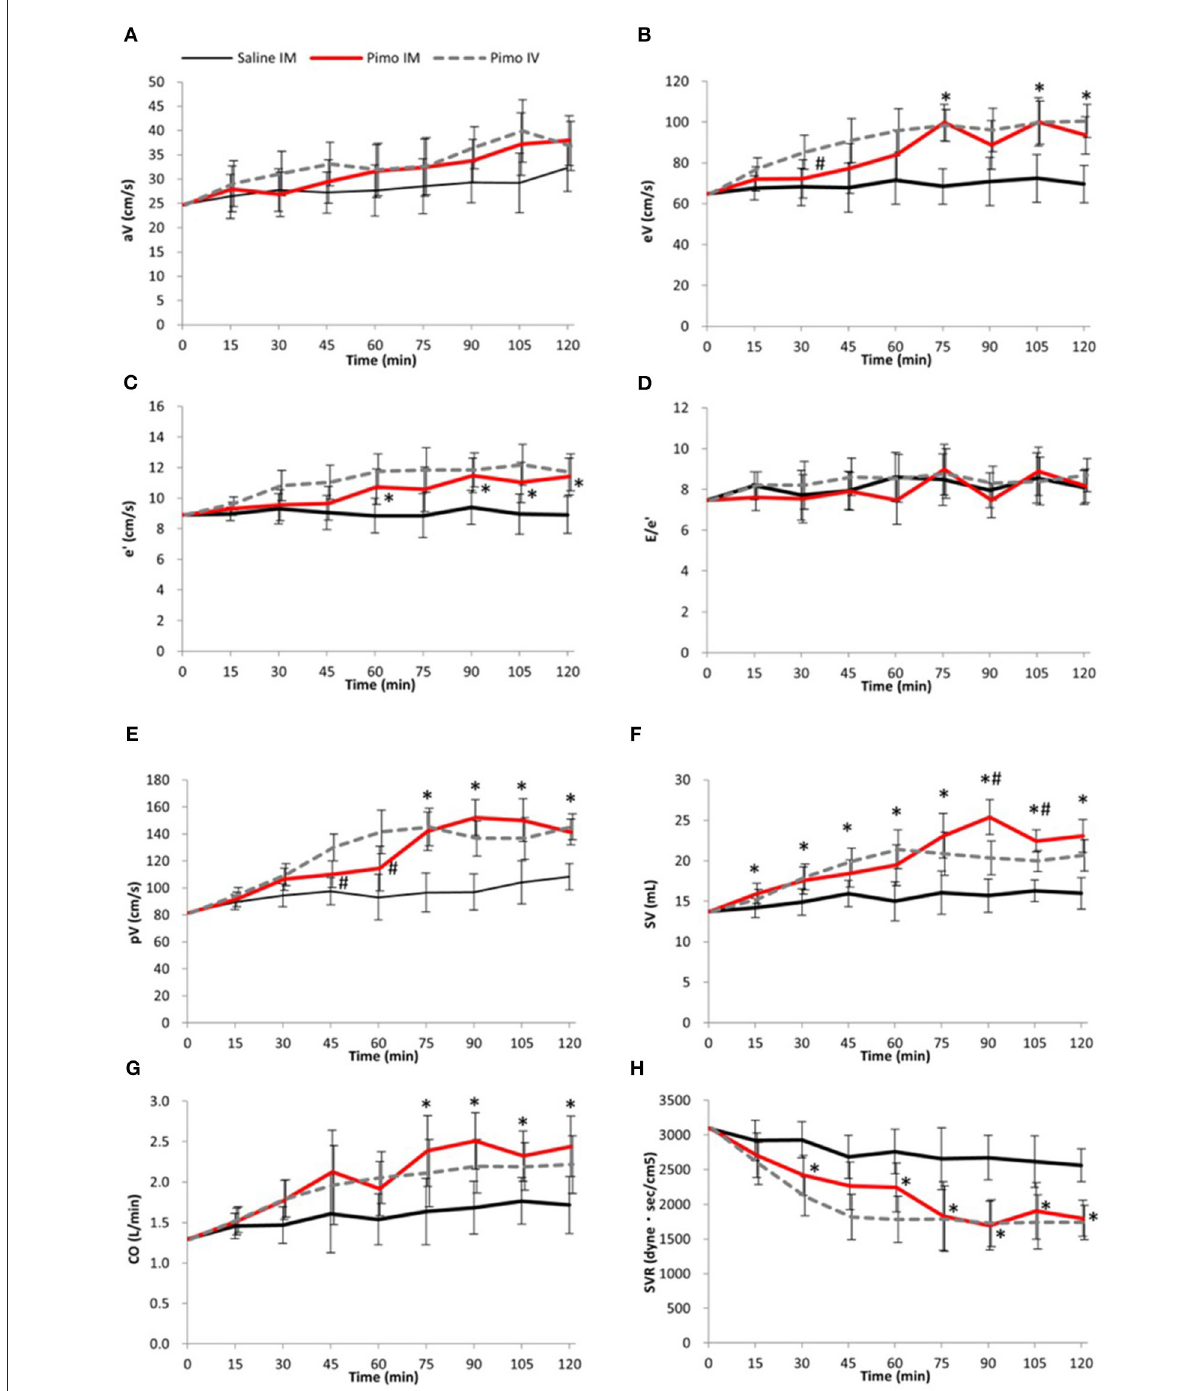
FIGURE2 Data are presented as mean ± 95% confidence interval (error bar). Black line: Saline IM; Red line: Pimobendan IM (Pimo IM); Gray dot line: Pimobendan IV (Pimo IV). (*) fitted to indicate the significant difference between Pimo IM and Saline IM, while (#) fitted to compare Pimo IM vs. Pimo IV [for the repeated measures ANCOVA (model: time, group, and time*group)]; P < 0.05. (A) Peak atrial filling velocity (aV, cm/s), (B) Early diastolic left ventricular filling velocity (eV, cm/s), (C) Peak early diastolic velocity of the mitral annulus (e ′ , cm/s), (D) Early diastolic left ventricular filling velocity/Peak early diastolic velocity of the mitral annulus ratio (E/e ′ ), (E) Peak velocity (pV, cm/s), (F) Stroke volume (SV, mL), (G) Cardiac output (CO, L/min), (H) Systemic vascular resistance (SVR, dyne · s/cm 5